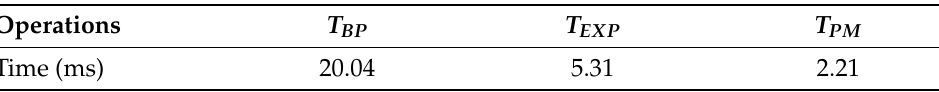
Table 4. Execution time for cryptographic